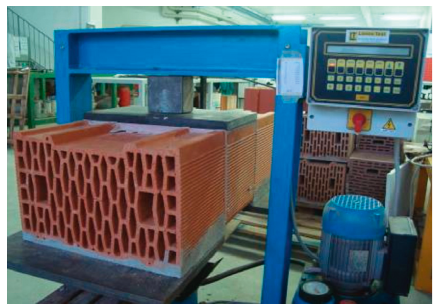
Figure 16: Positioning in the testing